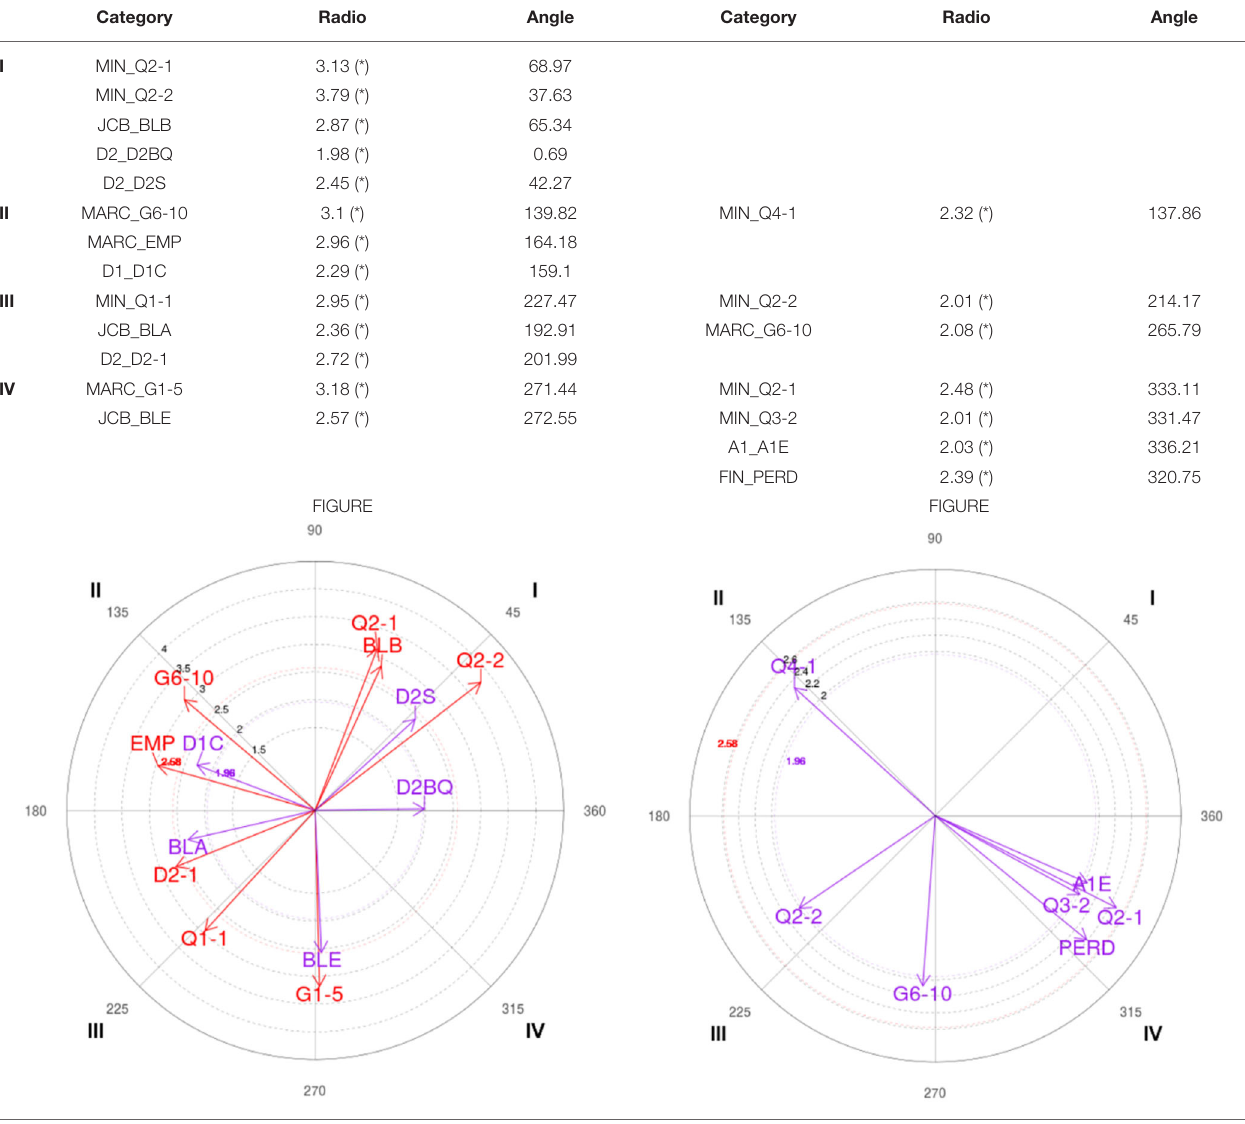
TABLE 6 | Significant relationships and vector representation between SLBQ focal behavior and mating behaviors for each gender.